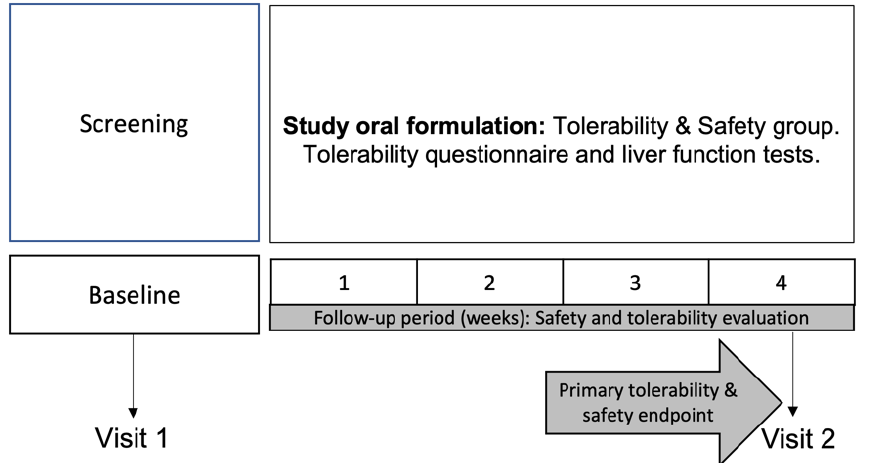
Figure 1. Safety and tolerability design. The safety and tolerability evaluation included the collection and summary of systemic adverse events, a tolerability questionnaire for oral formulations according to parameters of Mexico’s Pharmacopeia, and liver function tests. Primary efficacy analysis took place at visit 2 (week 4).